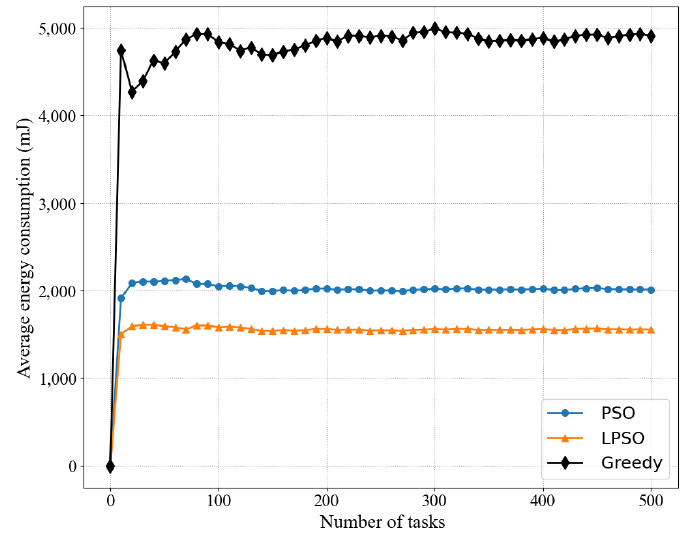
Figure 5. Comparing the average energy consumption of different algorithms in the same case where the weight of LPSO is V = 50.